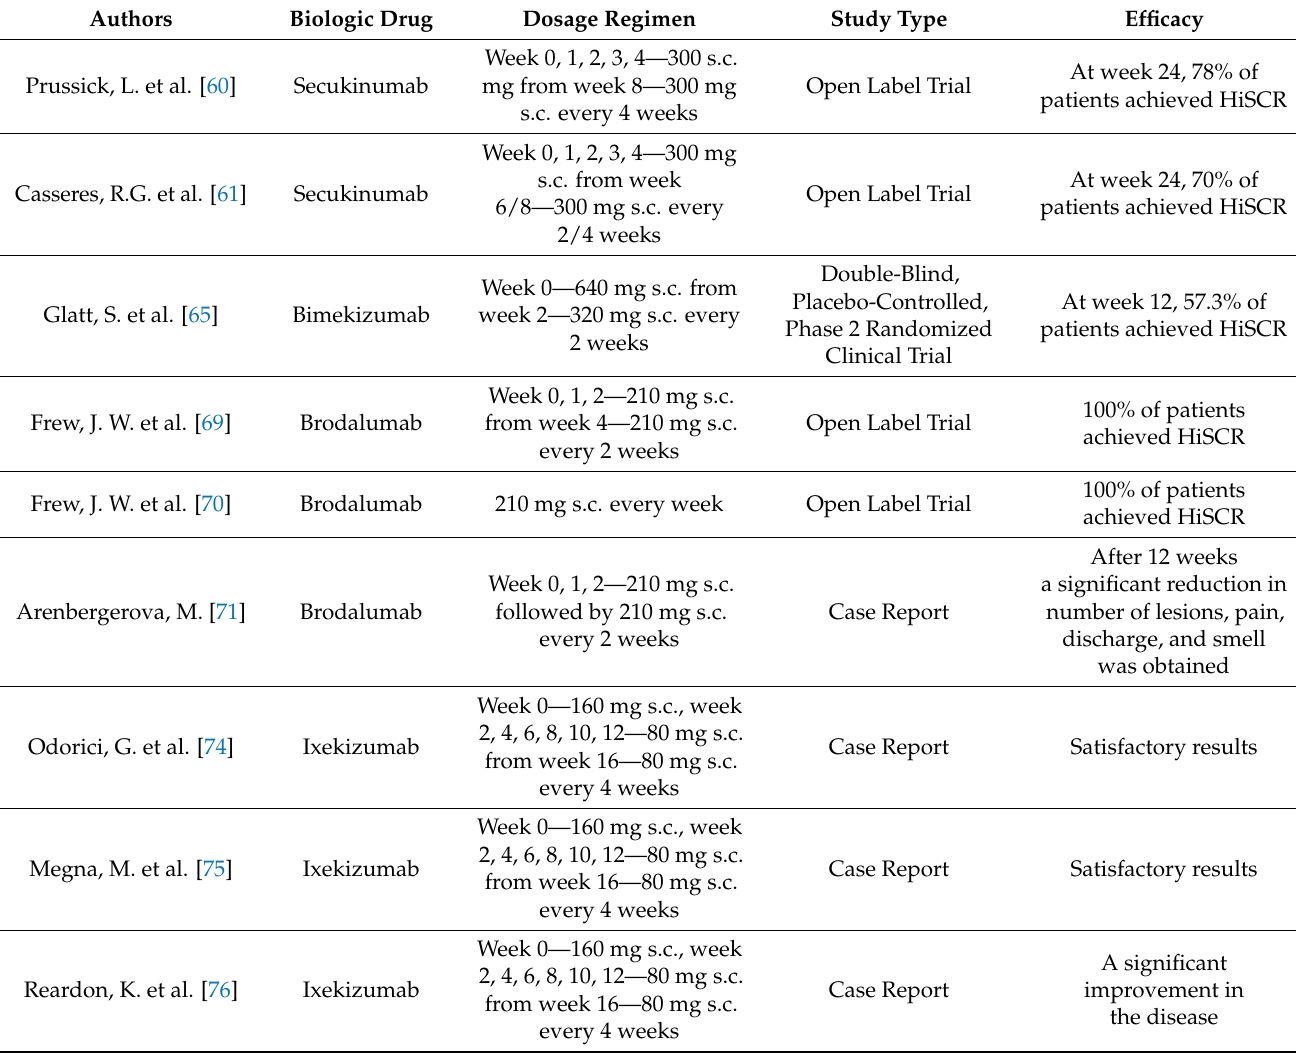
Table 2. A summary of significant clinical studies concerning the IL-17 inhibitors in